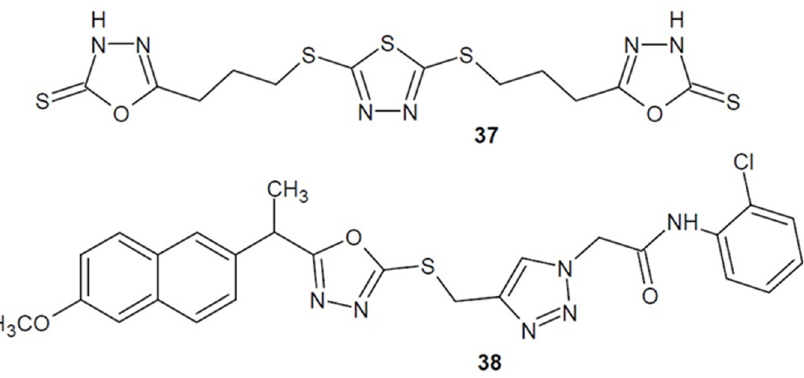
Figure 14. 1,3,4-oxadiazole-2-thiones/thiols and their S -substituted derivatives with antibacterial activity (part 1). In 2017, the team of Wang and Xie synthesized a series of 5-phenyl-1,3,4-oxadiazole- 2-thiol substituted N -hydroxyethyl quaternary ammonium salts (general structure 39 in